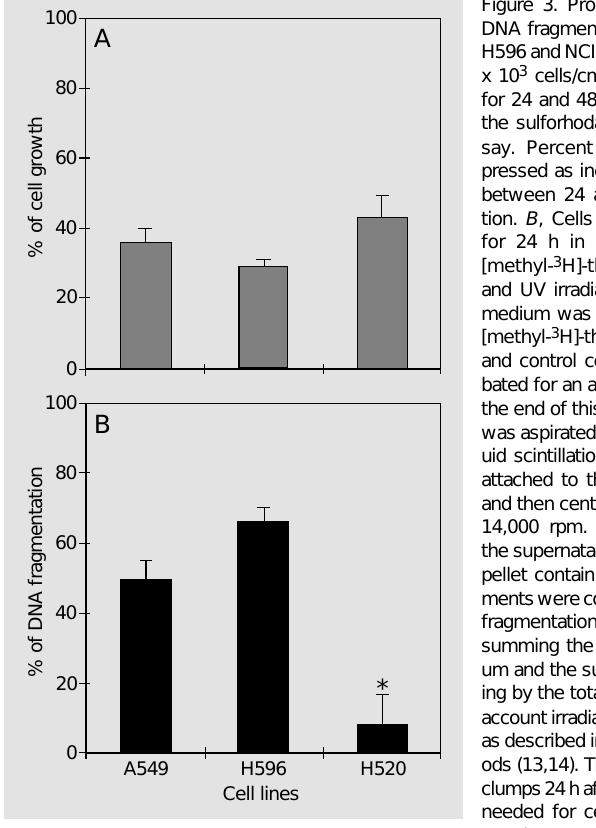
cell lines were irradiated as a uniform cell layer. Data are reported as the mean ± SD (N = 3) and are representative of at least three experiments. *P<0.01 compared to the others (Student t -test).